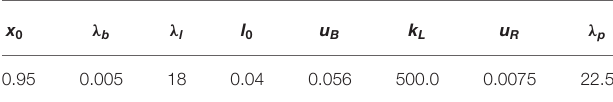
TABLE 1 | Standard non-dimensional parameters for the numerical simulations in section